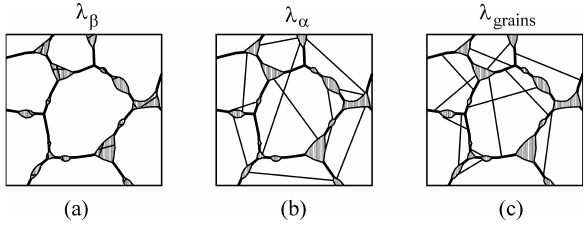
Figure 4. Illustration of the meaning of various measures of < λ >, the mean lineal intercept in a two phase microstructure structure: (a) λ β is the mean lineal intercept of the β phase; (b) λ α is the mean intercept of the α phase (the mean free path between β particles); (c) λ intercept of a grains.